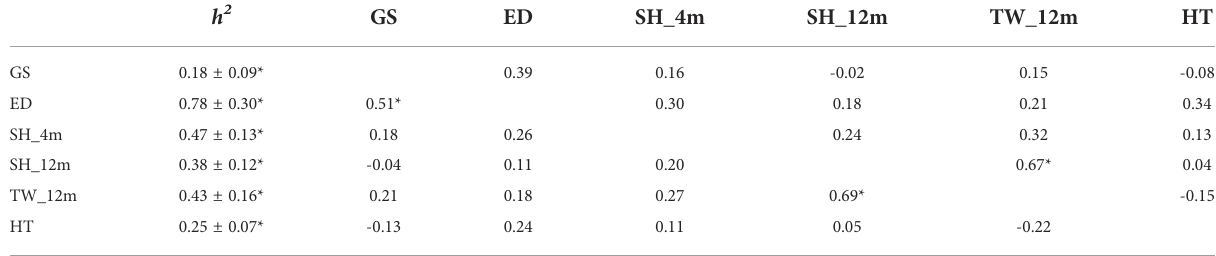
TABLE 2 Heritability estimates of gametogenic stage (GS), egg diameter (ED), shell height at 4 (SH_4m) and 12 months (SH_12m), total weight at 12 months (TW_12m), heat tolerance traits (HT), and genetic (above diagonal) and phenotypic (below diagonal) correlations between these